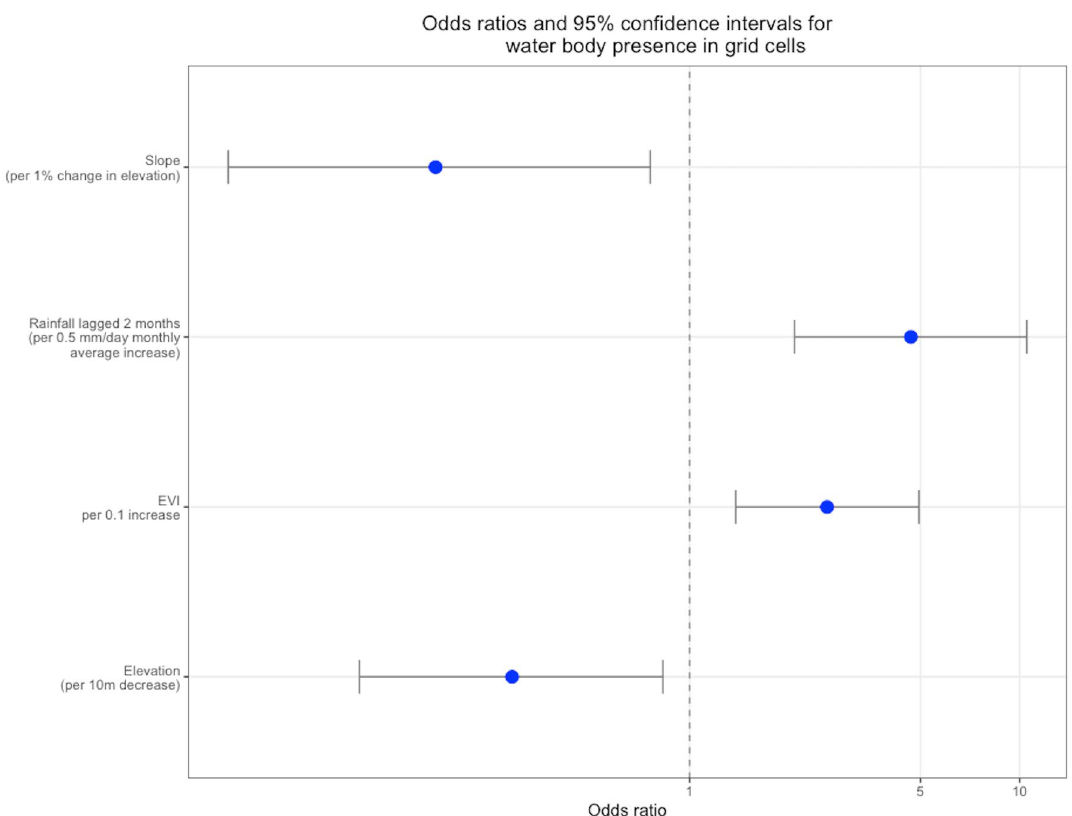
Figure 3. Odds ratios and 95% confidence intervals for risk factors for presence of water bodies within sampling